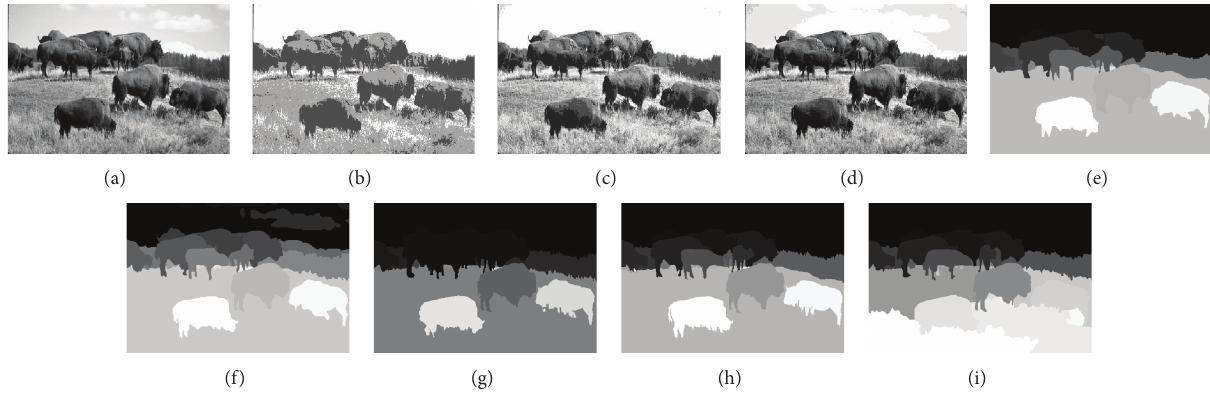
Figure 8: (a) Original image 38092, (b) M − 1 = 2 PRI = 0.74248 , (c) M − 1 = 5 PRI = 0.80876 , (d) M − 1 = 9 PRI = 0.79661 , (e)–(i) the ground-truth hand segmentations offered by Berkeley Segmentation Dataset.